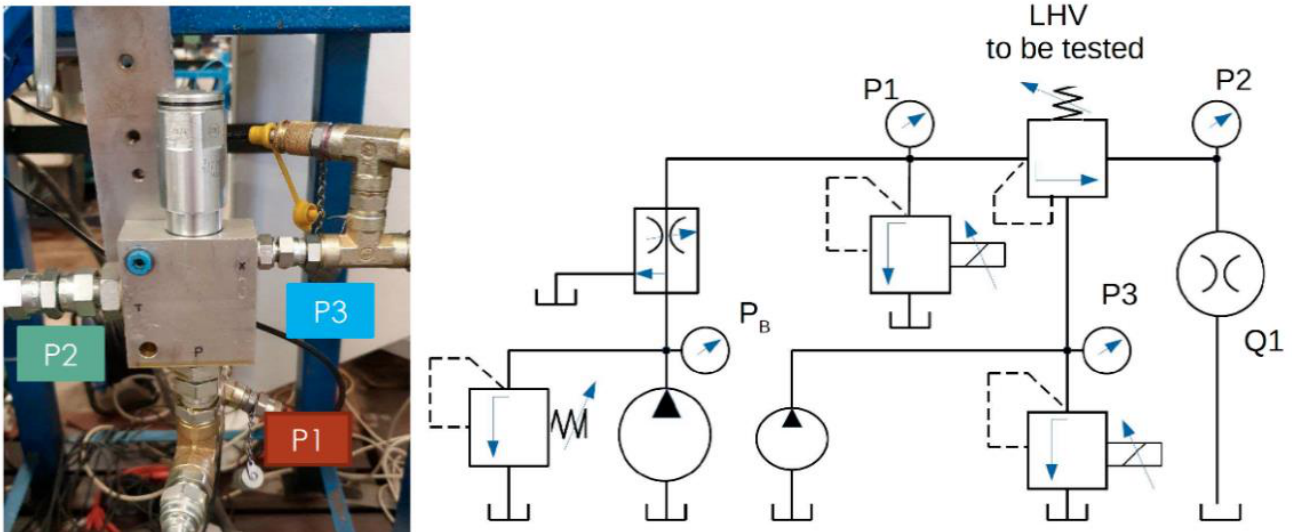
Figure 9. LHV-4 picture. Diagram of the hydraulic circuit used where: P 1 : upstream water pressure; P 2 : downstream pressure; P 3 : pilot pressure